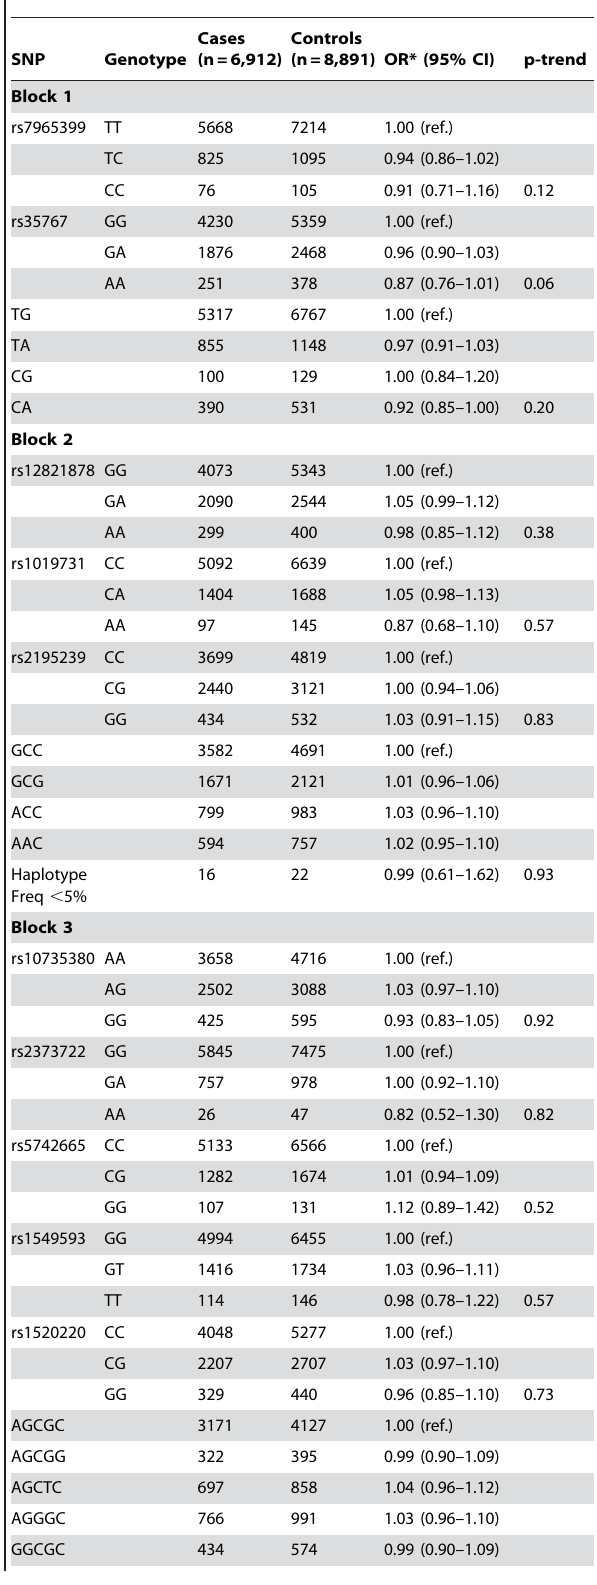
Table 3. Association of tagging SNPs of IGF1 and breast cancer risk in the